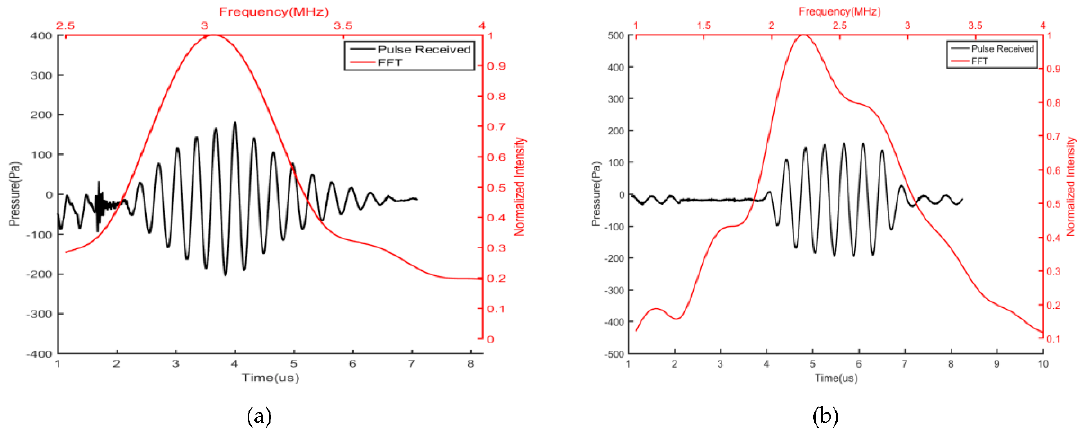
Figure 3. Acoustic pressure measurement with the hydrophone: ( a ) H 2 O at 3.8 mm; ( b ) FC-70 at 3 mm. In each figure, left axis and bottom axis (black) corresponds to the acoustic pressure and time respectively, while right axis and top axis (red) corresponds to the frequency domain.